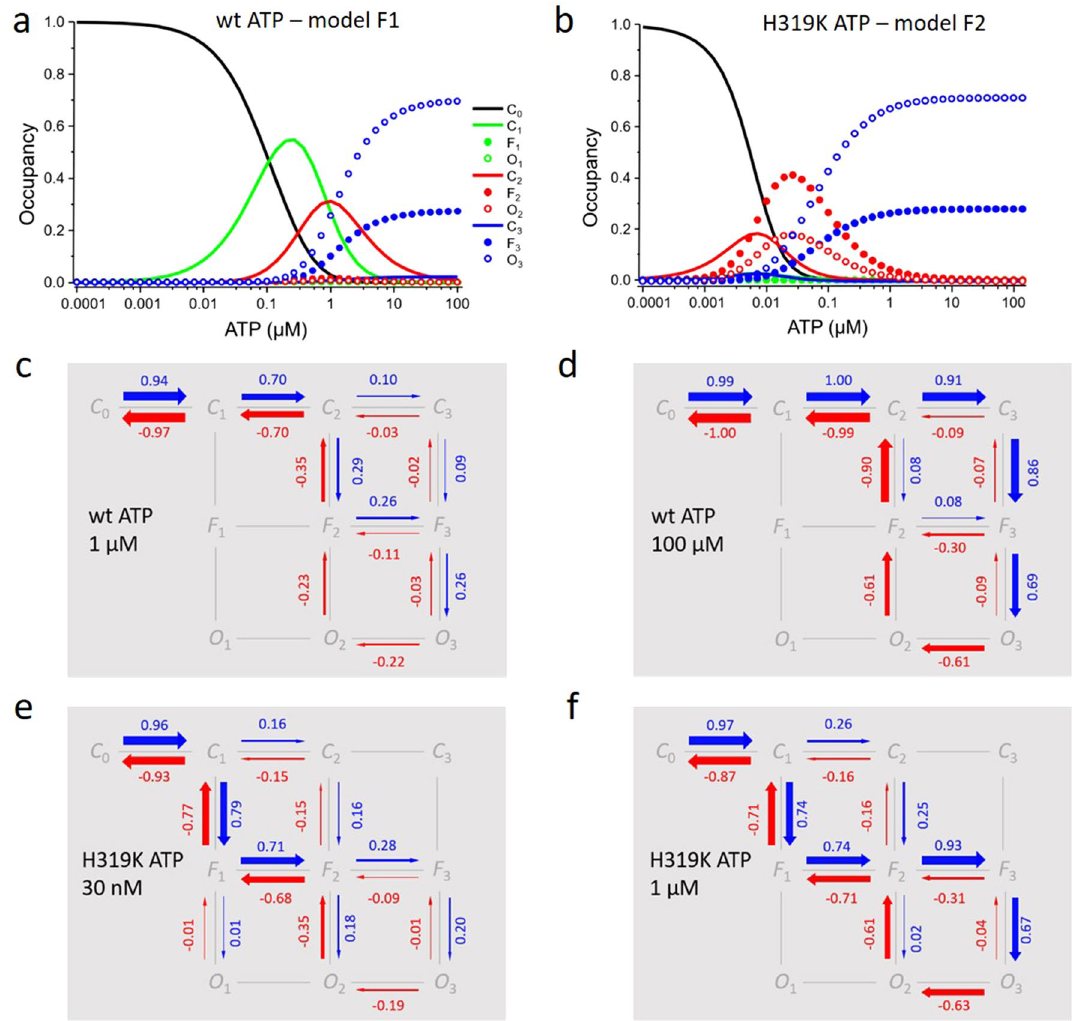
Figure 5. State occupancies at equilibrium and probability fluxes. ( a ) Occupancy of the states for wt channels as function of the ATP concentration according to model F1. ( b ) Occupancy of the states for H319K channels as function of the ATP concentration according to model F2. The partially liganded states F 2 and O 2 are significantly populated and contribute to the higher apparent affinity of the mutant. ( c ). Net probability fluxes in model F1 for wt channels when jumping the ATP concentration from zero to 1 μM (blue arrows) and back to zero (red arrows). The thickness of the arrows symbolizes the amount of net probability flux which is also specified by the adjacent numbers. Net probability fluxes below 0.01 were omitted. ( d ) As c but with 100 μM ATP. € Net probability fluxes in model F2 for H319K channels when jumping the ATP concentration from zero to 30 nM and back to zero. Same symbolism as in ( c ). ( f ) As ( e ) but with 1 μM